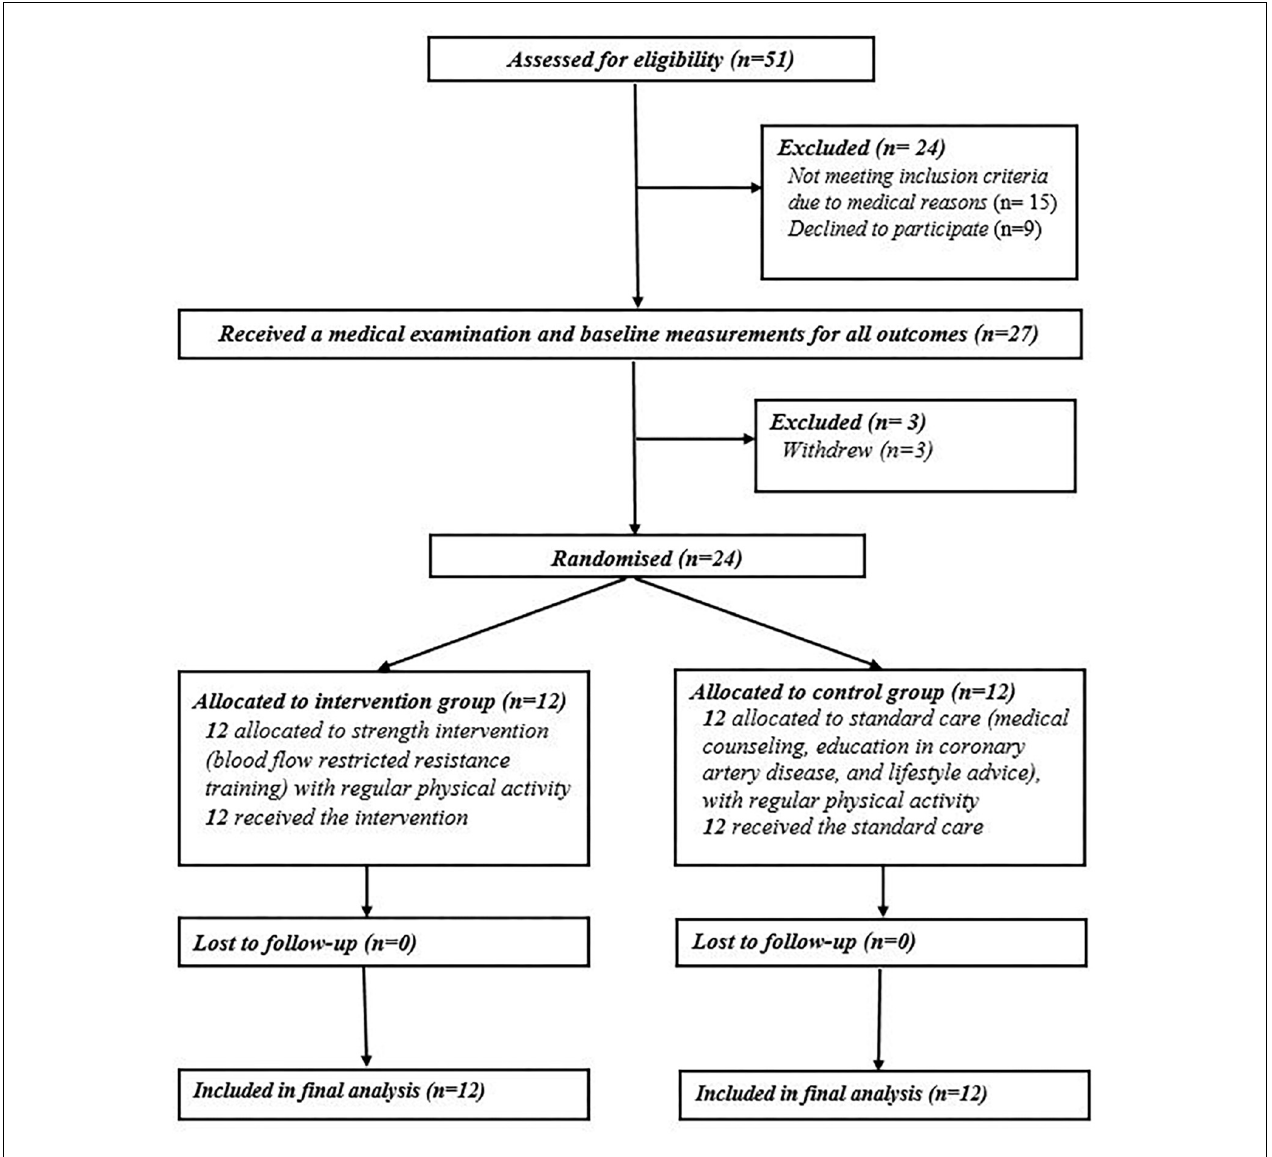
FIGURE 1 | Flow diagram of parallel